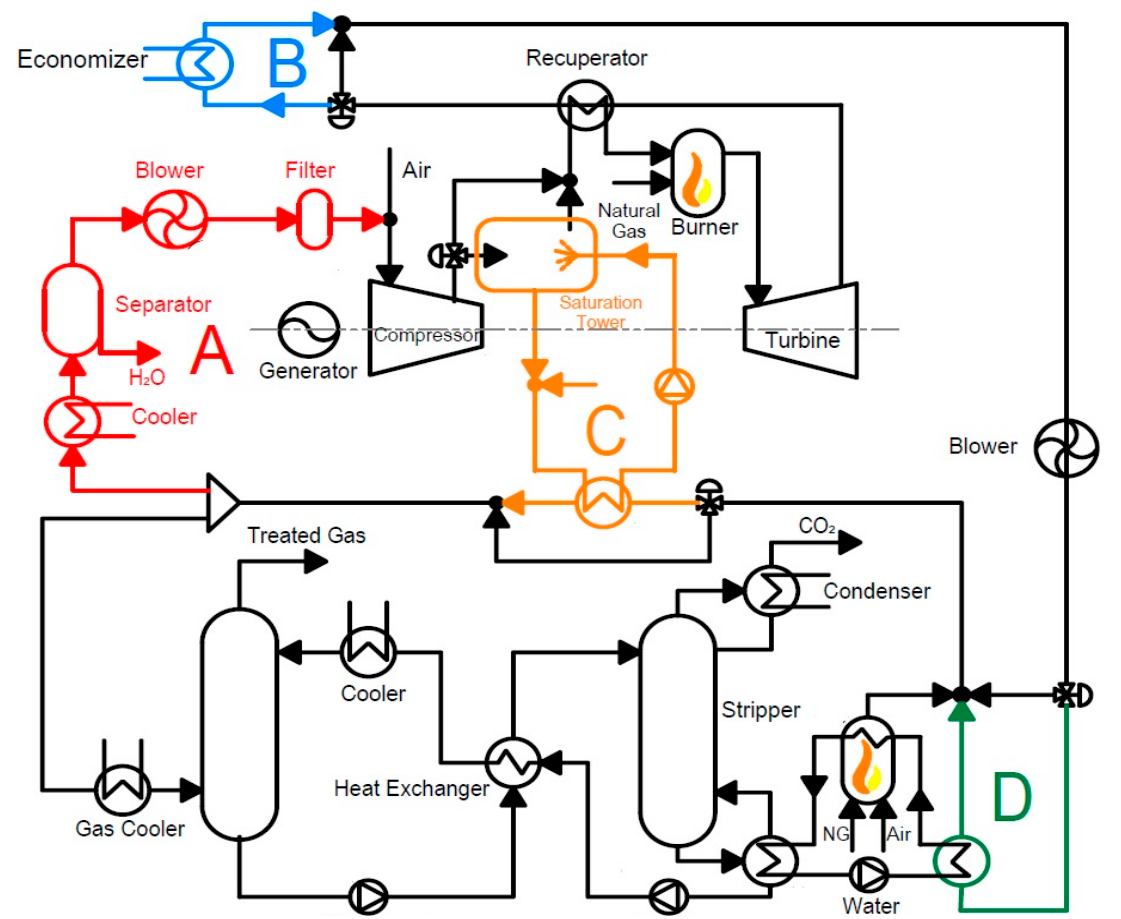
Figure 7. Plant layout displaying the standard EGR in block A, the CHP application in block B, and, in the case of no heat demand where block B is bypassed, block C for humidification and block D for reboiler duty are activated (adapted from [78]).